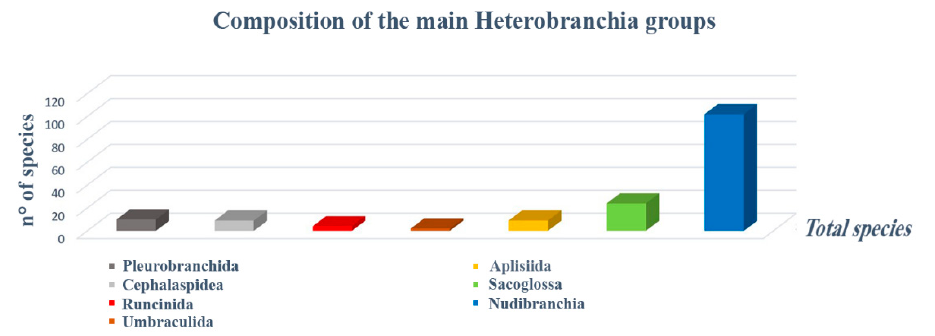
Figure 10. Comparison between the main heterobranch groups; the graph shows the comparison between the total species of the Salento Peninsula, clustered into the main groups.